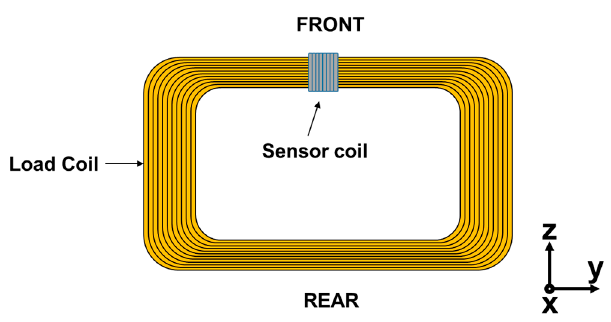
Figure 8. Configuration of the sensor coil within the load coil. Shown from a top view perspective.